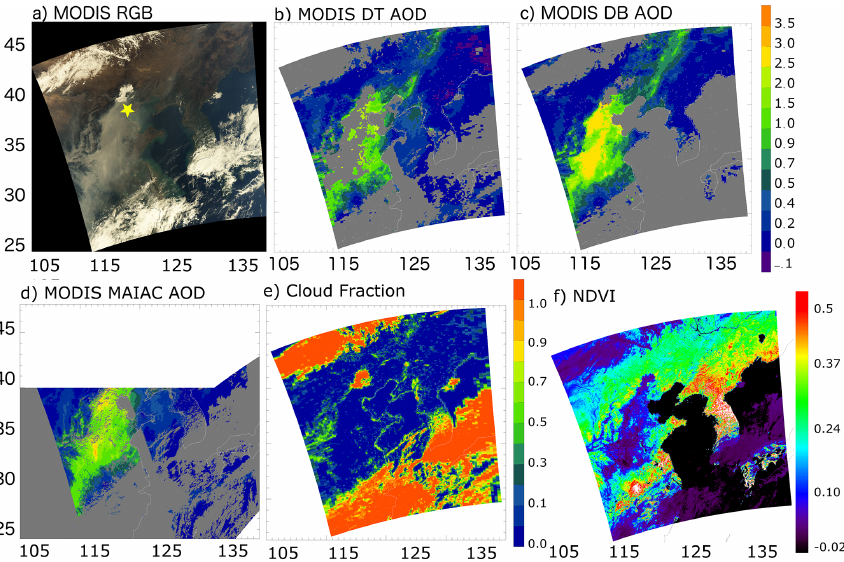
Figure 1. A case study of a pollution event over eastern China on 9 October 2013. (a) MODIS Aqua RGB image; (b) MODIS Dark Target (DT) AOD at 0.55µm for all available retrievals (QA = 0 to 3); (c) MODIS Deep Blue (DB) AOD at 0.55µm for all available DB retrievals (QA = 0 to 3); (d) MODIS MAIAC AOD; (e) MODIS DT Cloud Fraction, a diagnostic of the MODIS aerosol product; (f) normalized difference vegetation index, used as the inland water mask by the DT algorithm. The yellow star represents the AERONET site